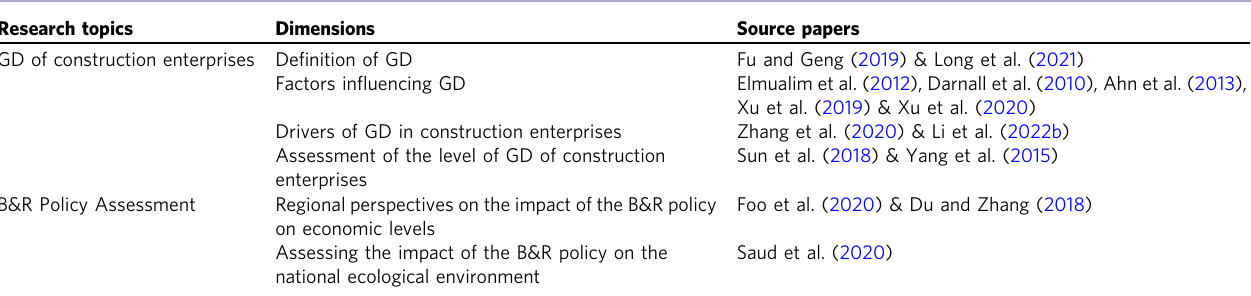
Table 1 Studies related to the GD of construction enterprises and the evaluation of the B&R